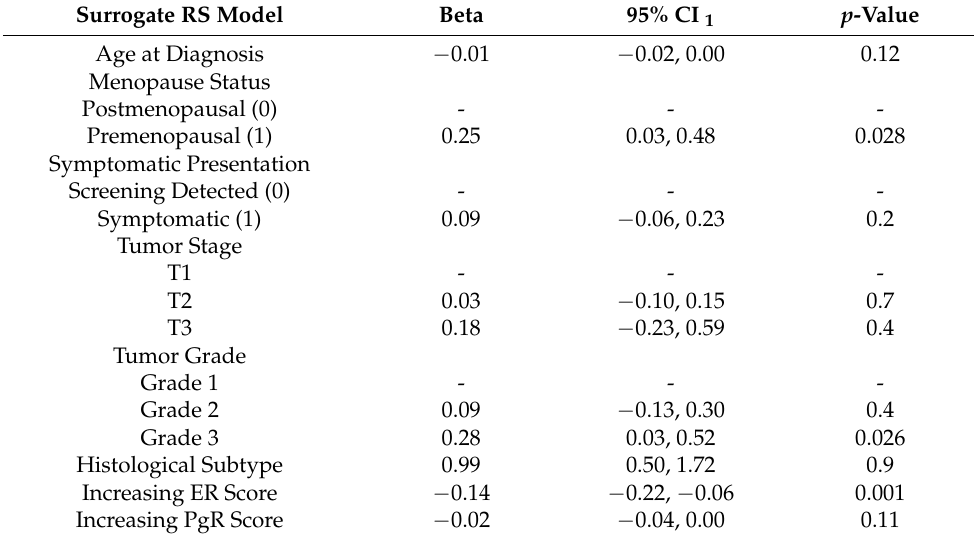
Table 2. Multivariable linear regression analysis to predict clinicopathological data capable of predicting continuous Recurrence Score.